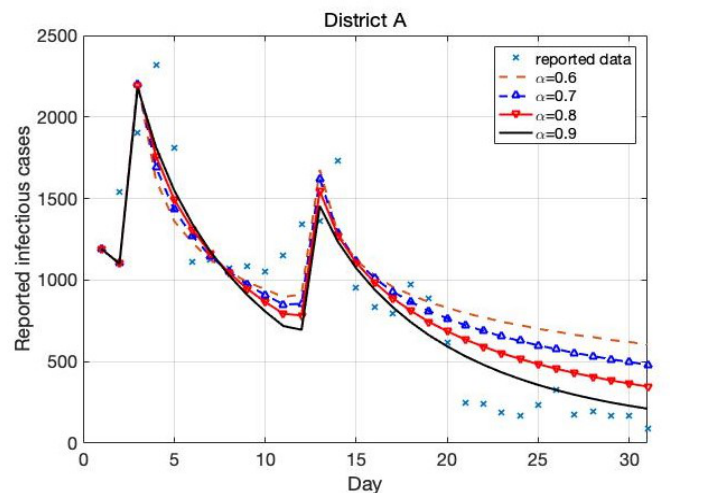
Figure 5. Model results for infected